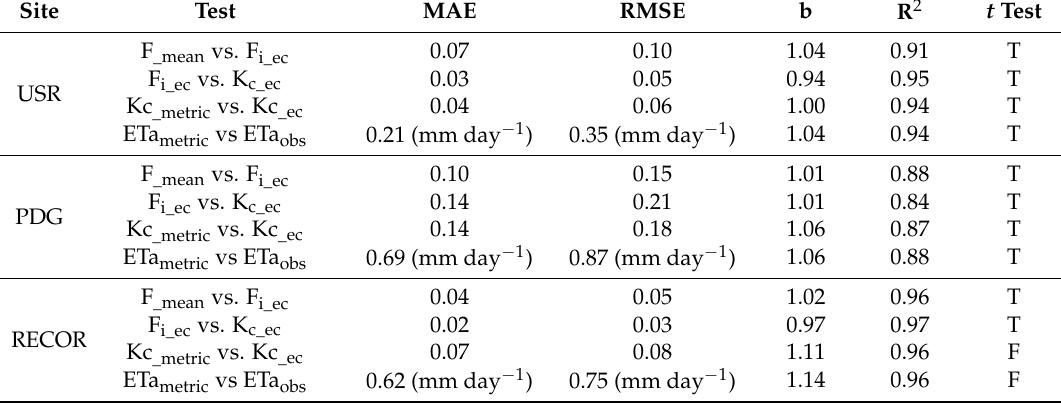
Table 6. Statistical analysis results for reference evapotranspiration fraction (F) and daily evapotranspiration (ETa). F i_ec is the instantaneous observed F, F mean is the diurnal (8:00–18:00) mean value of F, Kc_ ec is the Kc observed for each experimental site, Kc_ metric is the Kc estimated by METRIC, ETa obs is the observed